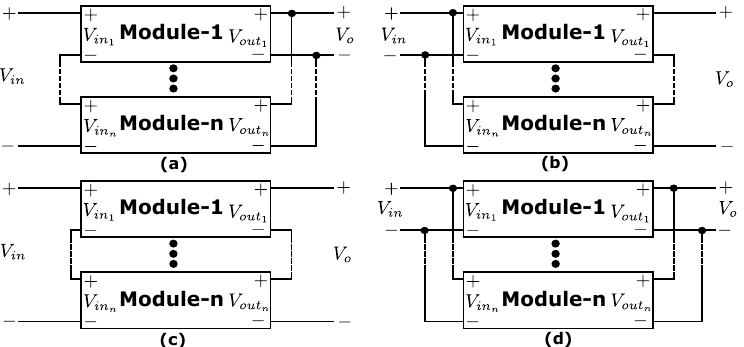
Figure 19. Four connections of series-parallel converter system. ( a ) Input-series–output-parallel. ( b ) Input-parallel–output-series. ( c ) Input-series–output-series. ( d ) Input-parallel–output-parallel.